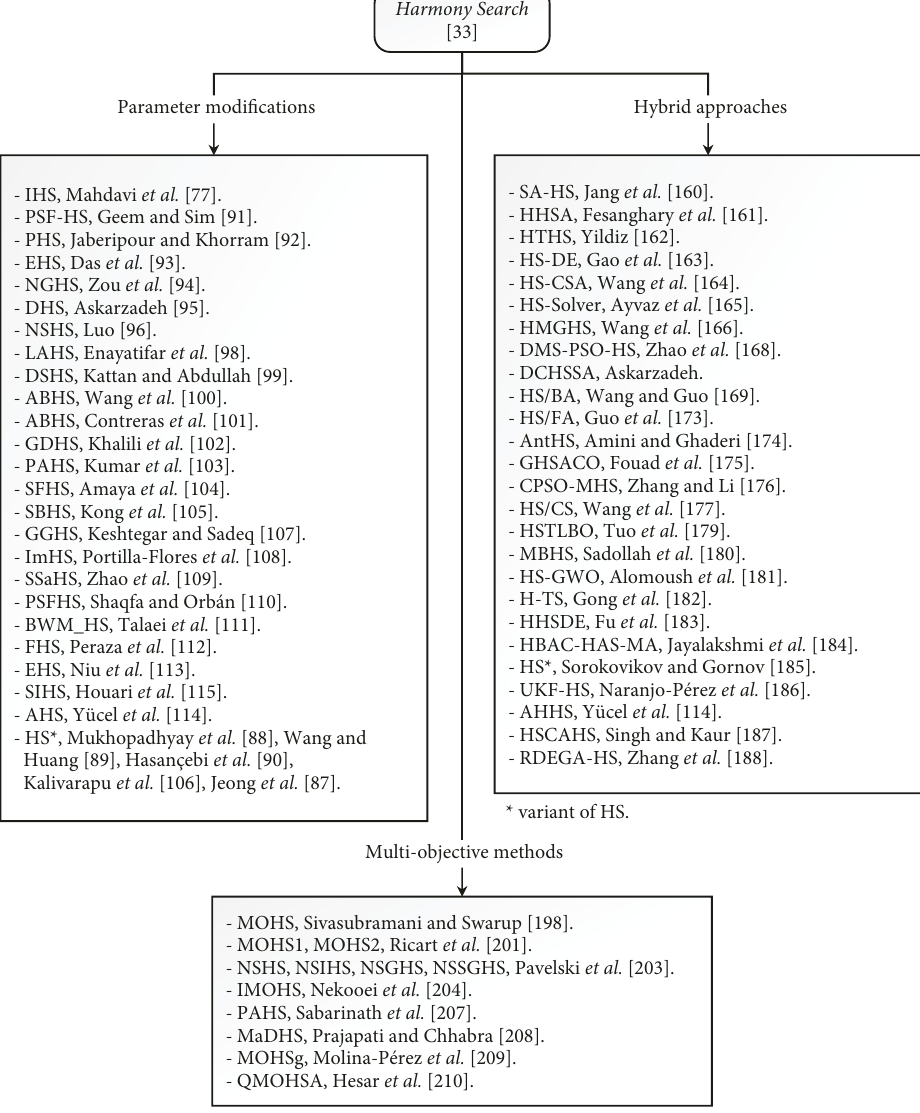
Figure 4: Harmony search variants grouped by the parameter-based modifications, hybrid approaches, and multi-objective